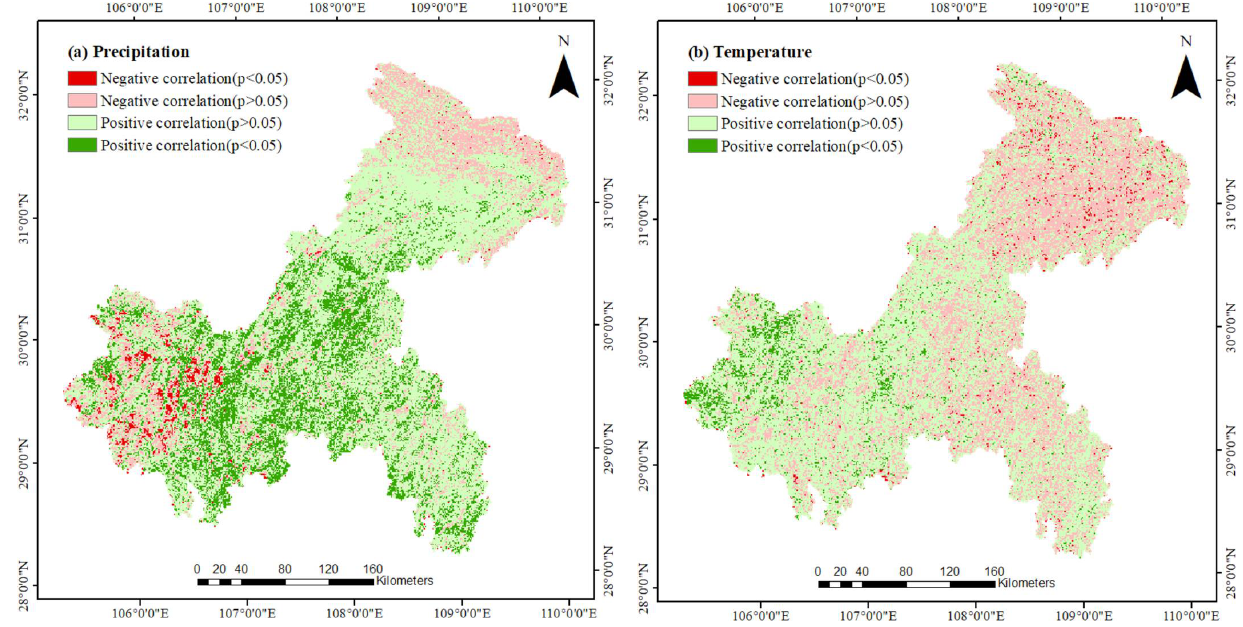
Figure 6. Spatial distribution of correlation coefficients between vegetation cover and ( a ) precipitation and ( b ) temperature from 2000–2020. Table 3. Correlation of vegetation cover with climatic factors.